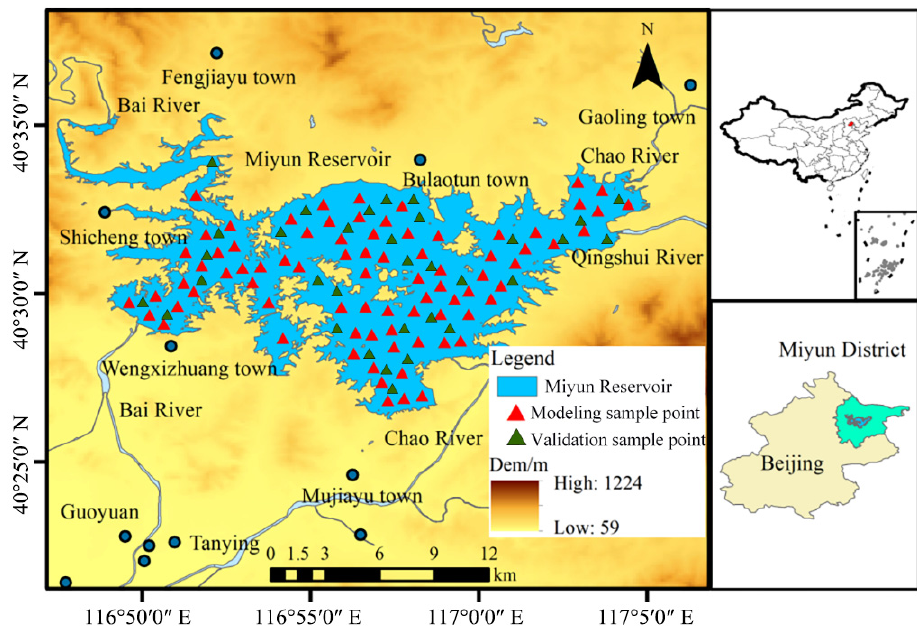
Figure 1. Location of Miyun Reservoir and sampling